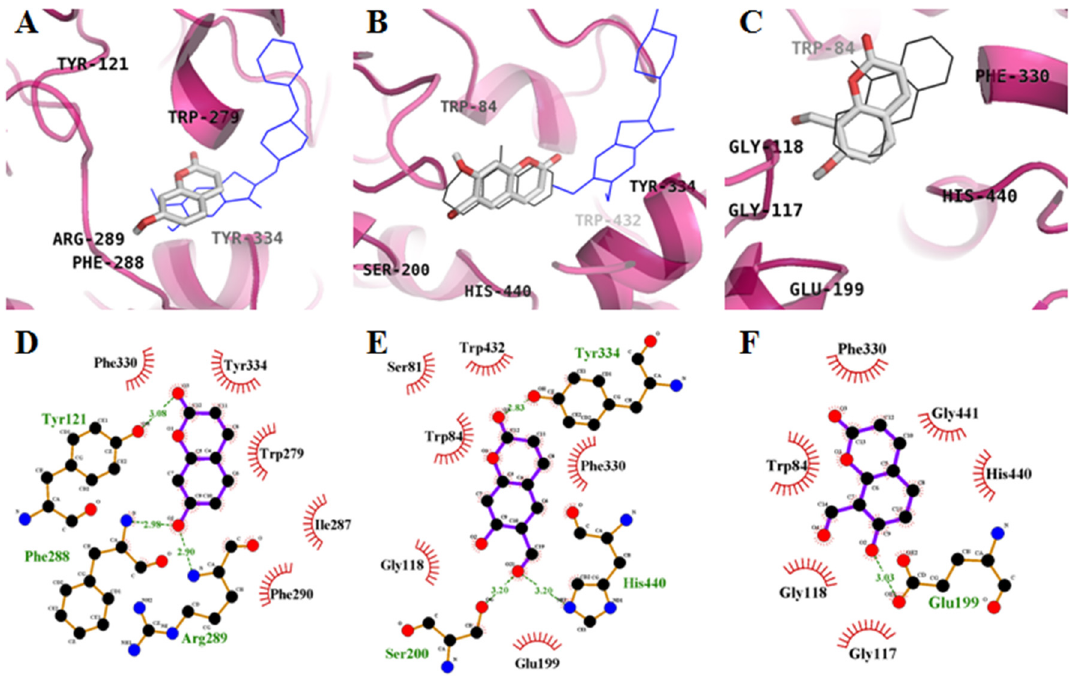
Figure 3. Molecular docking models of AChE inhibition by 1 ( A ), 2 ( B ), and 3 ( C ) with THA (black line) and donepezil (blue line). Ligand interaction diagram of AChE inhibition of 1 ( D ), 2 ( E ), 3 ( F ). Dashed lines indicate hydrogen bonds. Carbons are in black, nitrogens in blue, and oxygens in red. Figures were generated using PyMOL (v1.7.4, Schrödinger, LLC, Cambridge, MA, USA) and Ligplot+ (v1.4.5, European Bioinformatics Institute, London, England). Table 2. Molecular interaction of the acetylcholinesterase active site with 1 – 3 and the inhibitors THA and donepezil.